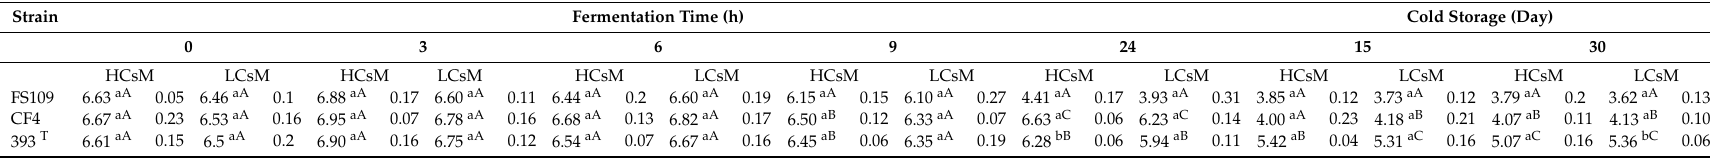
Table 3. Evolution of pH values in HCsM and LCsM bulk milk fermented with L. paracasei strains during fermentation time and cold storage.